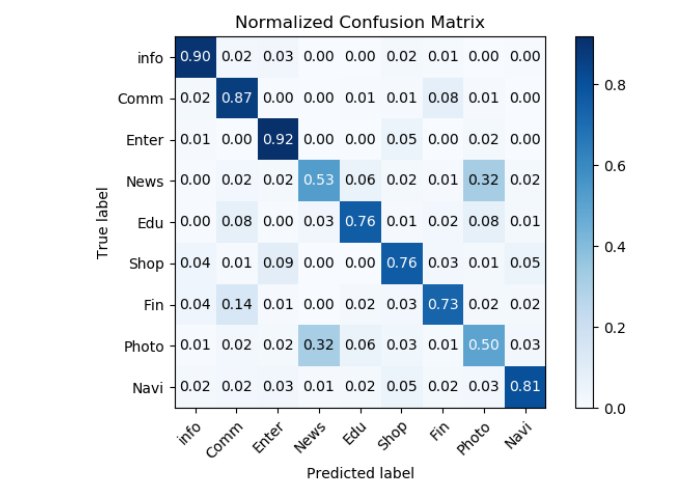
Figure 6. Confusion matrix